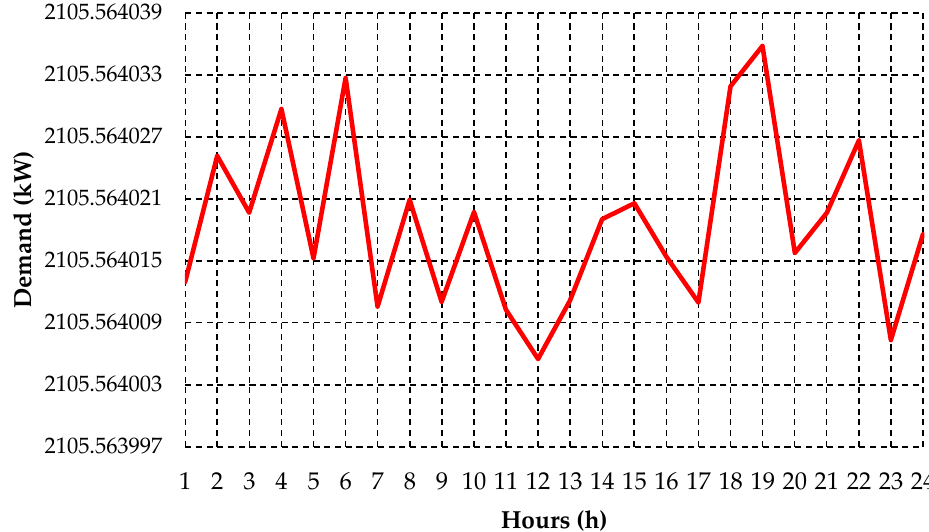
Figure 25. Daily demand profile of irrigator customers resulting from load shifting at the Rural Feeder C. Source: The authors.